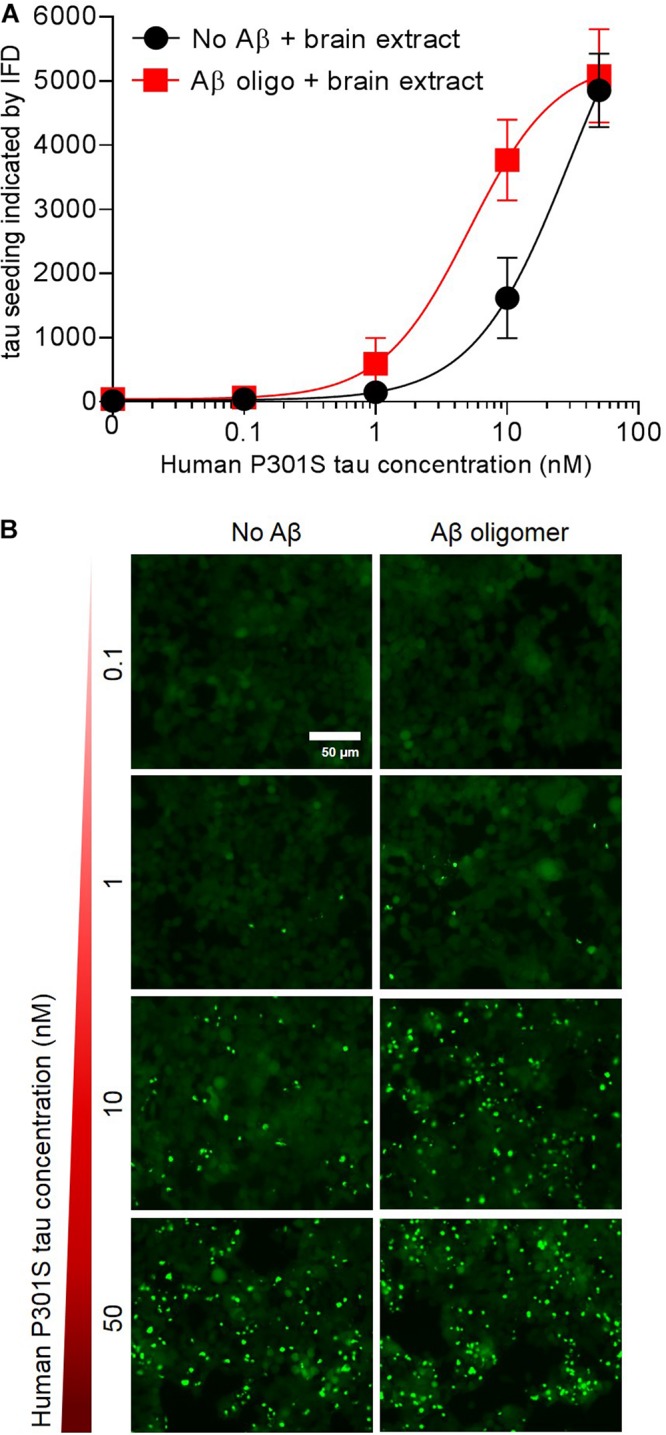
Aβ promotes tau seeding with brain extract from mice expressing human full-length P301S tau. (A) Tau seeding of biosensor cells transduced with PS19 mouse brain extract as measured by Integrated FRET Density (IFD). The concentration of human tau in the brain extracts was quantified using ELISA. The data are presented as mean ± SD (n = 6). (B) Representative fluorescent images of treated tau biosensor cells.